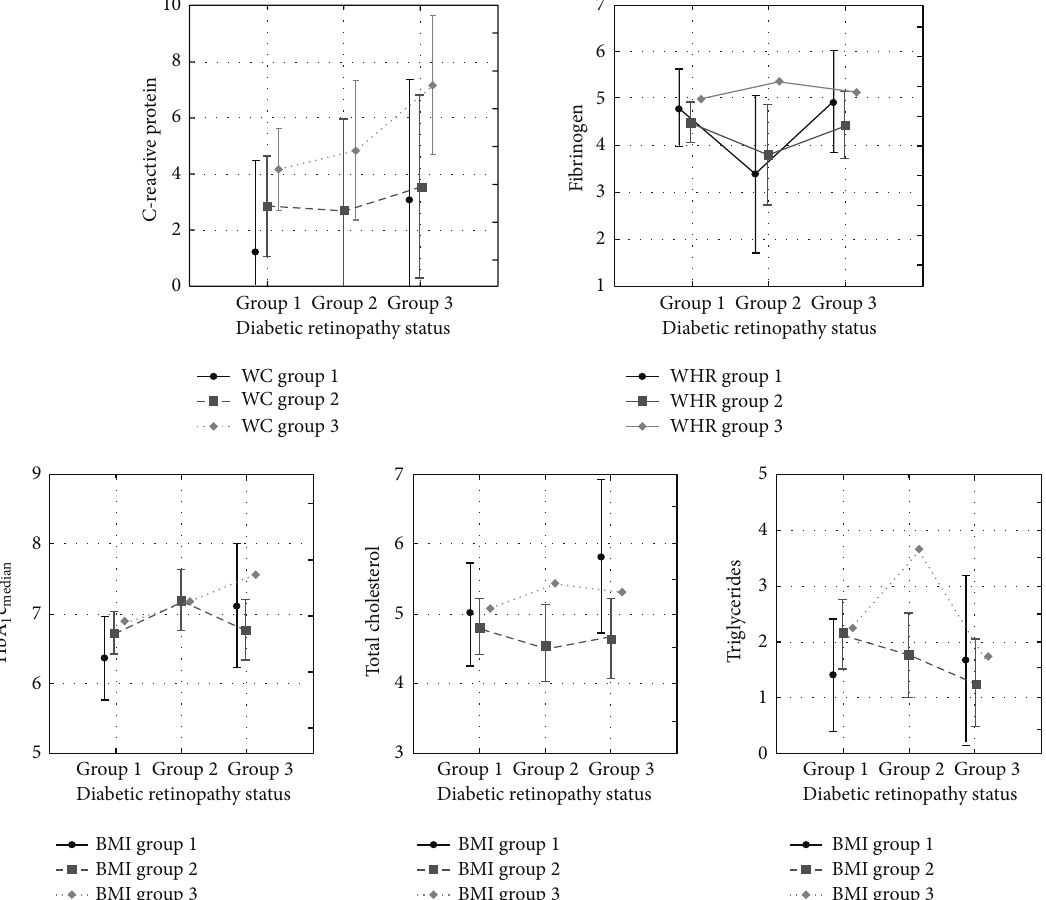
Figure 1: Vertical bars denote 0.95 confidence intervals. BMI: body mass index (kg/m 2 ); WC: waist circumference (cm); WHR: waist-to-hip , total cholesterol, and triglycerides in type 2 diabetic ratio. Statistically significant differences in C-reactive protein, fibrinogen, HbA 1 c median patients divided into three groups according to the diabetic retinopathy status and the level of obesity defined by BMI, WC, and WHR.